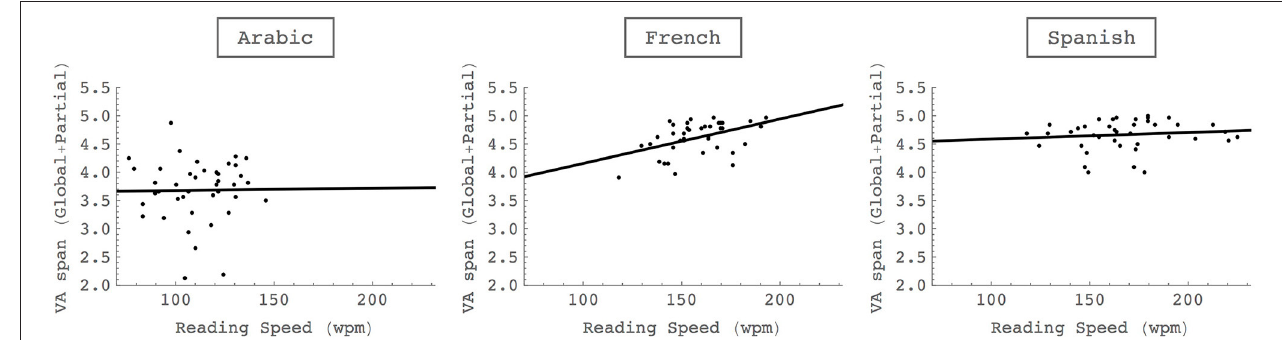
FIGURE 3 | Correlations between VA span and text reading speed in French, Spanish and